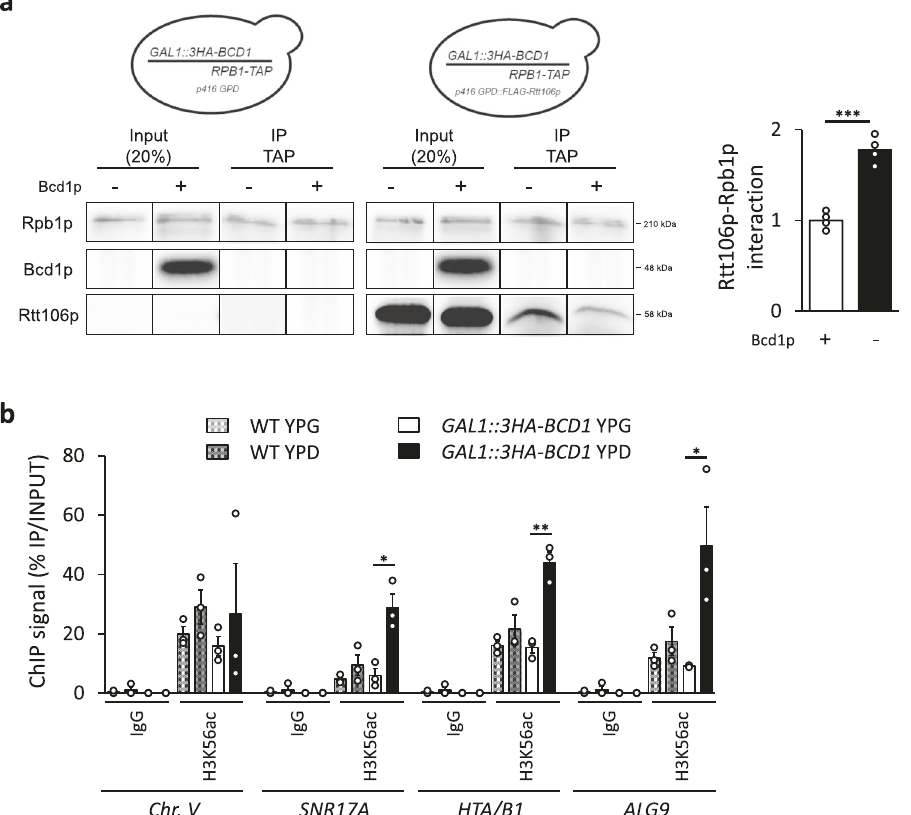
Fig. 4 Bcd1p controls transcription-dependent activity of Rtt106p. a Interaction of Bcd1p with the RNA polymerase II large subunit Rpb1p in yeast. Co- immunoprecipitation (co-IP) was performed on GAL1::3HA-BCD1 × RPB1-TAP cells transformed with p416GDP::FLAG-Rtt106p expressing 3xHA-tagged Bcd1p, TAP-tagged Rpb1p and FLAG-Rtt106p. Cells were transformed with empty vector p416GDP as a control. Cells were grown in YPG ( + Bcd1p) or